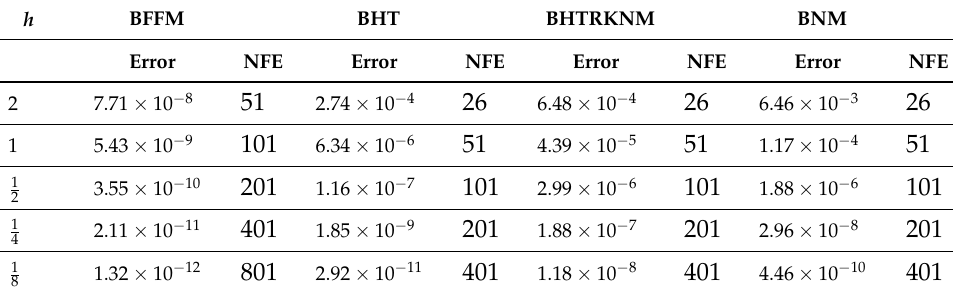
Table 1. Data for Example 1 with ω = 1, δ = 10 − 3